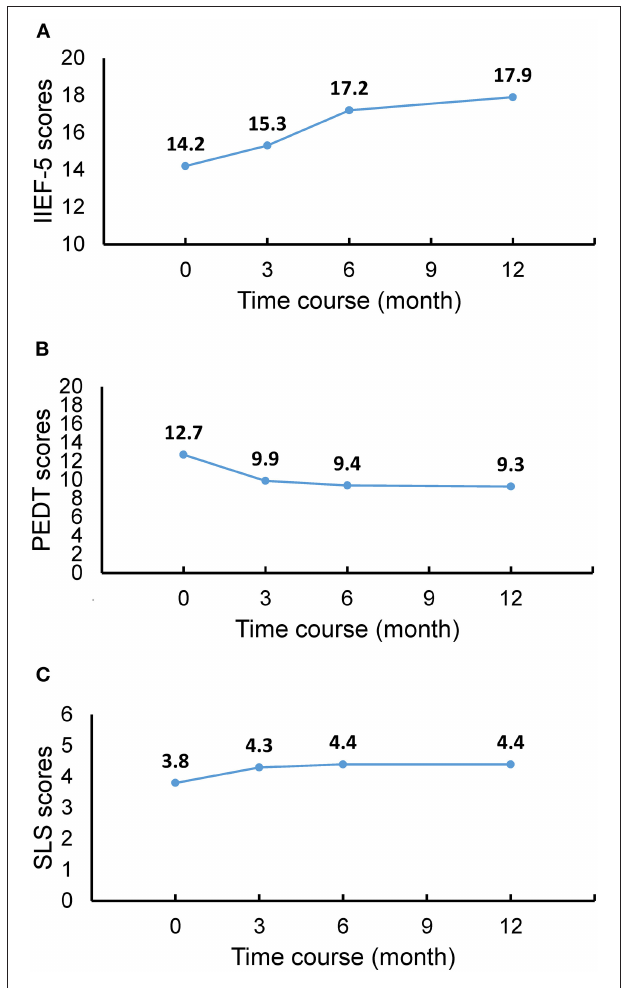
FIGURE 3 | Sexual function recovery after bladder stone ex at various time-points. (A) IIEF-5 scores. (B) PEDT scores. (C) SLS scores. The results show consistent improvement in sexual function after surgical removal of bladder stones. IIEF-5, International Index of Erectile Function-5; PEDT, Premature Ejaculation Diagnostic Tool; SLS, Sexual Life Satisfaction